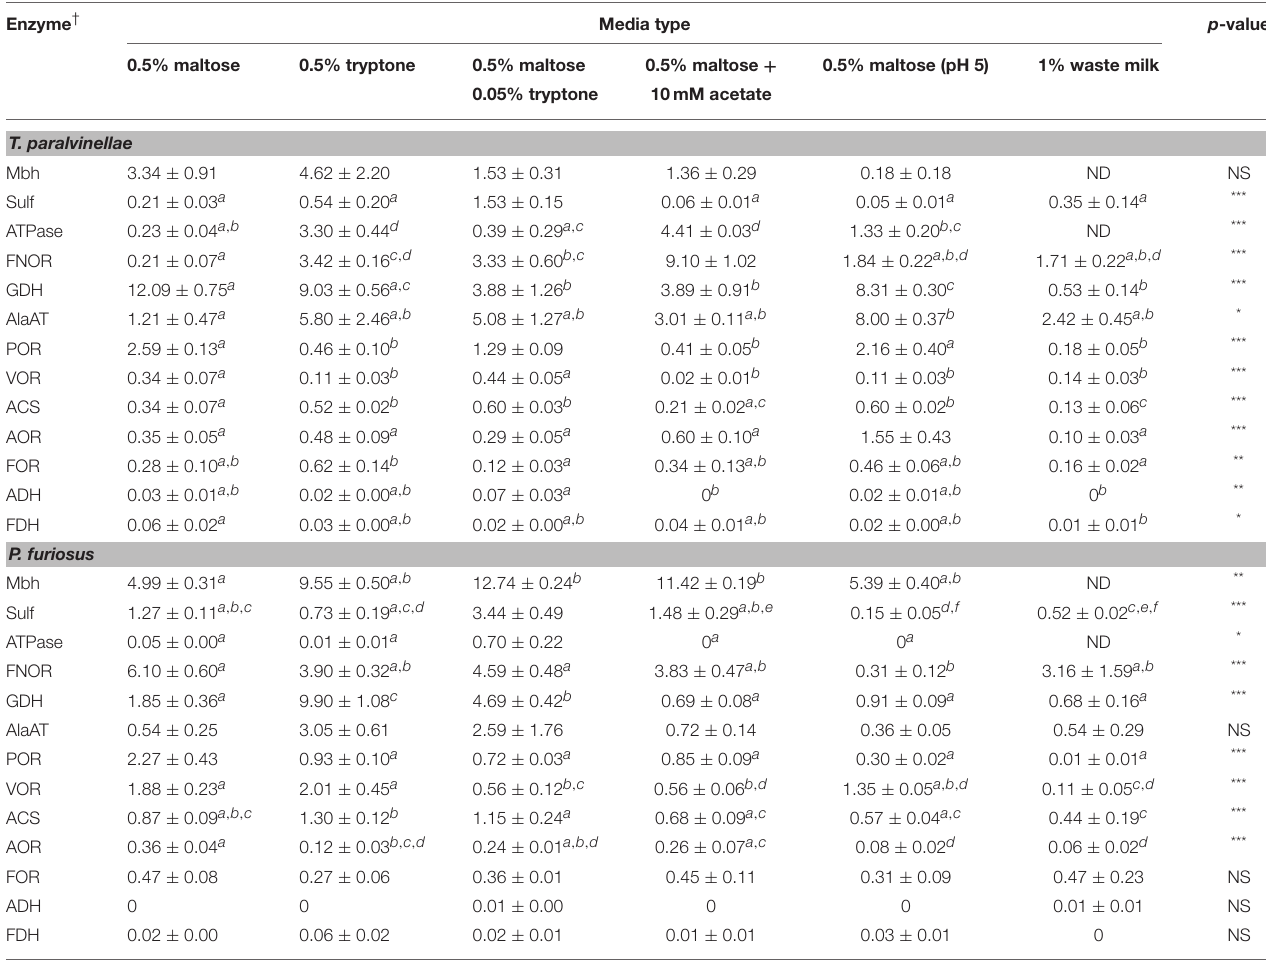
TABLE 4 | T. paralvinellae and P. furiosus specific enzyme activities.